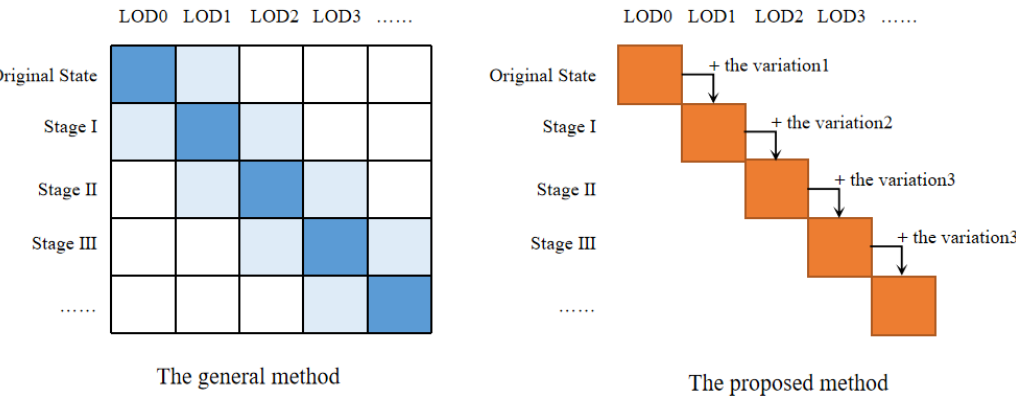
Figure 10. General transformation method compared with method based on continuous LOD topological data structure.